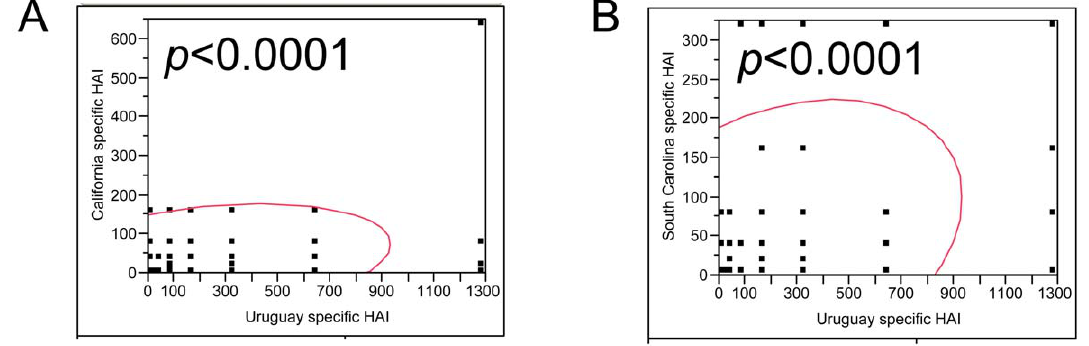
Figure 3. Correlation of antibody titers specific for seasonal vaccine strains and pandemic viruses after seasonal vaccination. Serum samples were collected on 21 days after administration of 2009–2010 inactivated unadjuvanted trivalent influenza vaccine (TIV) in US healthy adults and elderly. An HAI assay was performed using 0.5% turkey erythrocytes. A correlation analysis between seasonal strain specific HAI titers and pandemic strain specific HAI titers was performed using nonparametric Spearman’s r test by JMP Version 7. The scatterplots of HAI titers are shown in the presence of 95% bivariate normal density ellipses (indicating the distribution of 95% of individual data points plotted) and corresponding p values. A, A/California/07/2009 (H1N1) vs A/Uruguay/716/2007 (H3N2); B, A/South Carolina/18/2009 (H1N1) vs A/Uruguay/716/2007 (H3N2).